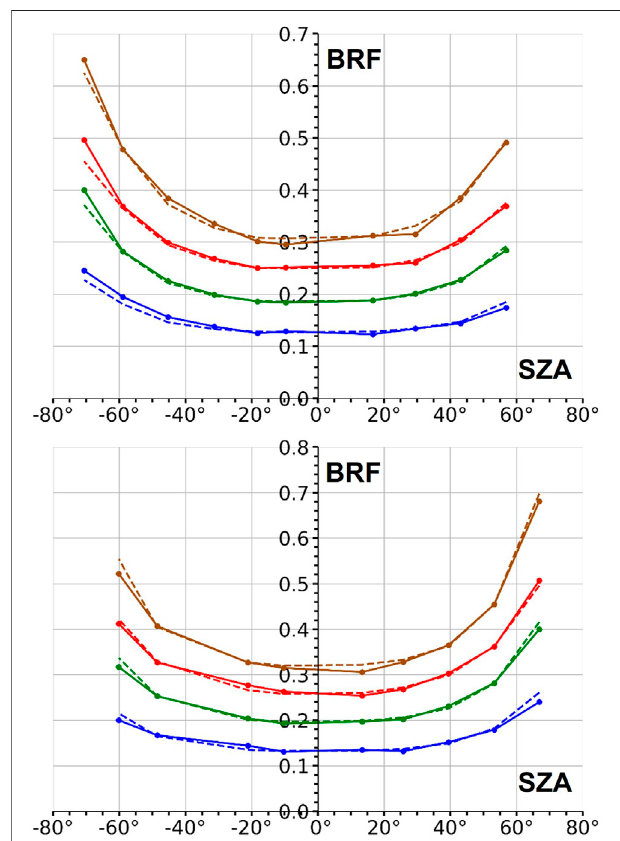
FIGURE 6 | An example of the retrieved BRF (dots connected by solid lines) and the best- fi t BRDF model (dashed lines) for the bright surface pixel displayed in Figure 5 . The BRF and BRDF are shown for 2 different days in June of 2020 in RGB bands (in respective color) and in the NIR (in brown). The SZA is positive in the morning, and negative in the